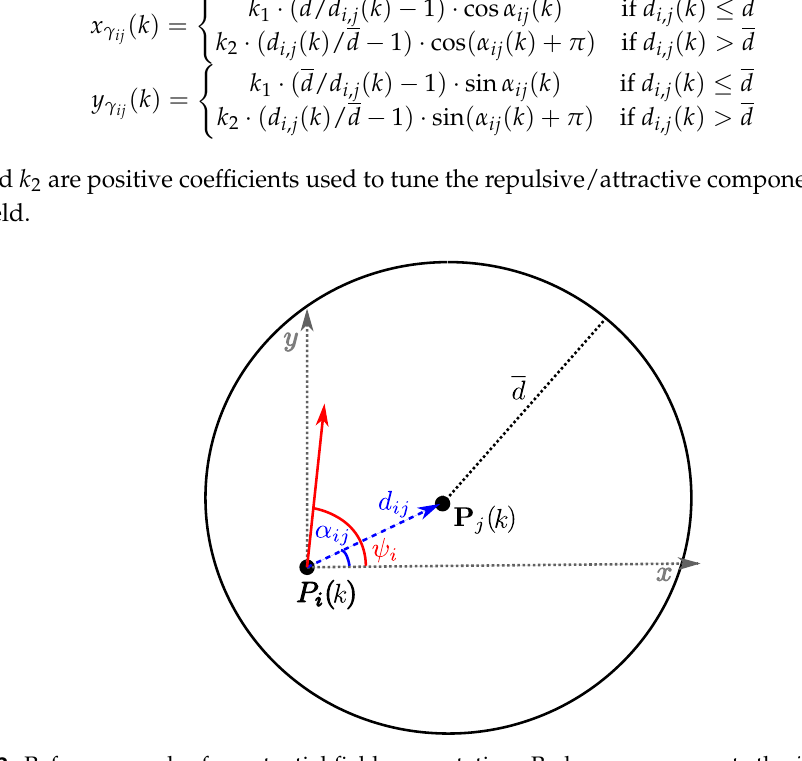
Figure 2. Reference angles for potential field computation. Red arrow represents the i -th vehicle’s flight direction. The repulsive force driven by j forces vehicle i to stay on the circumference with a radius equal to the desired distance d